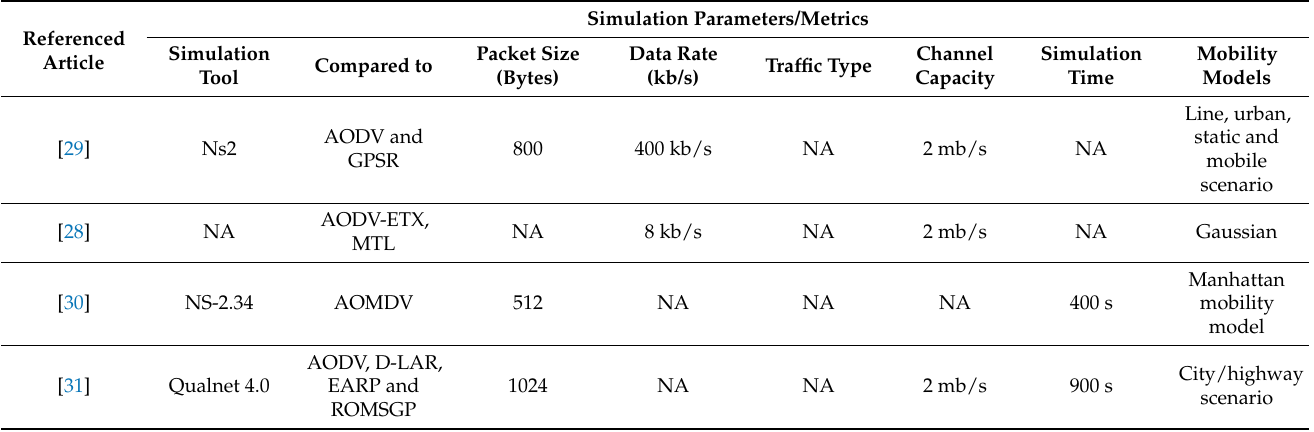
Table 6. Simulation parameters of hybrid scenario-based routing protocols.